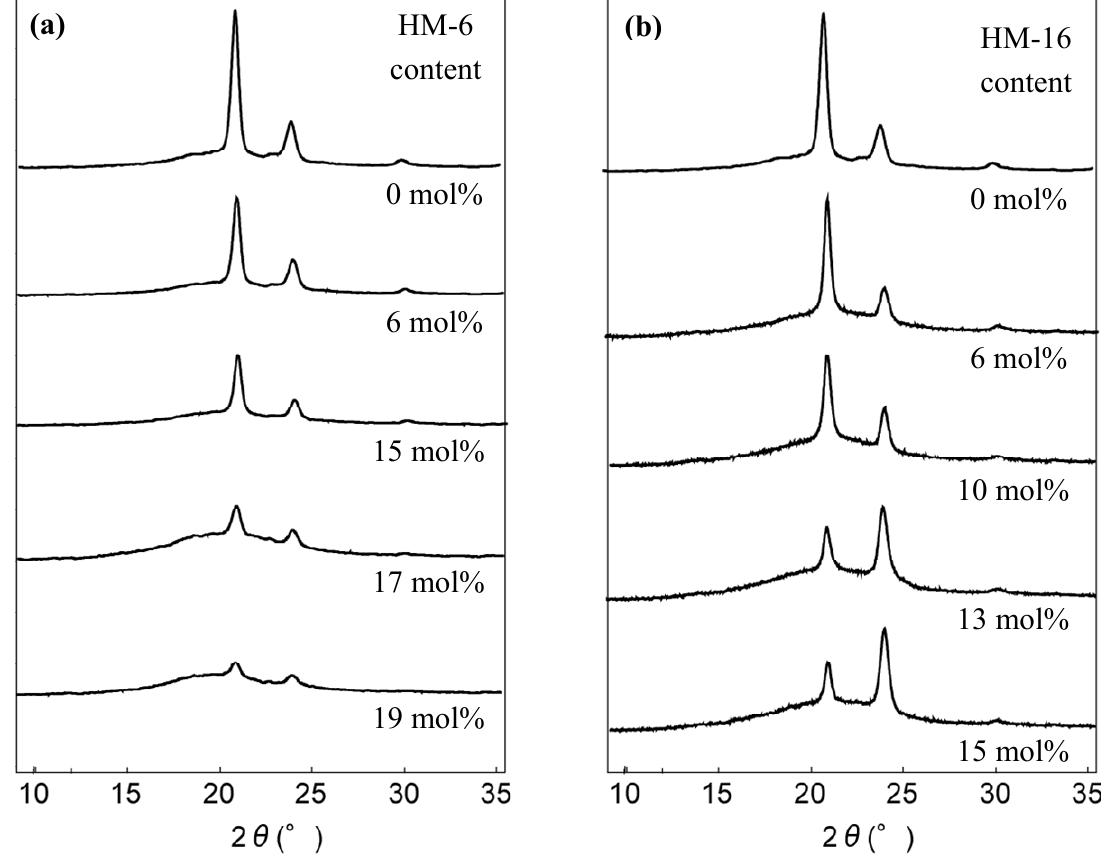
Figure 4. Wide angle X-ray diffraction spectra of ( a ) PHS/M-6 and ( b ) PHS/M-16 films with various monomer